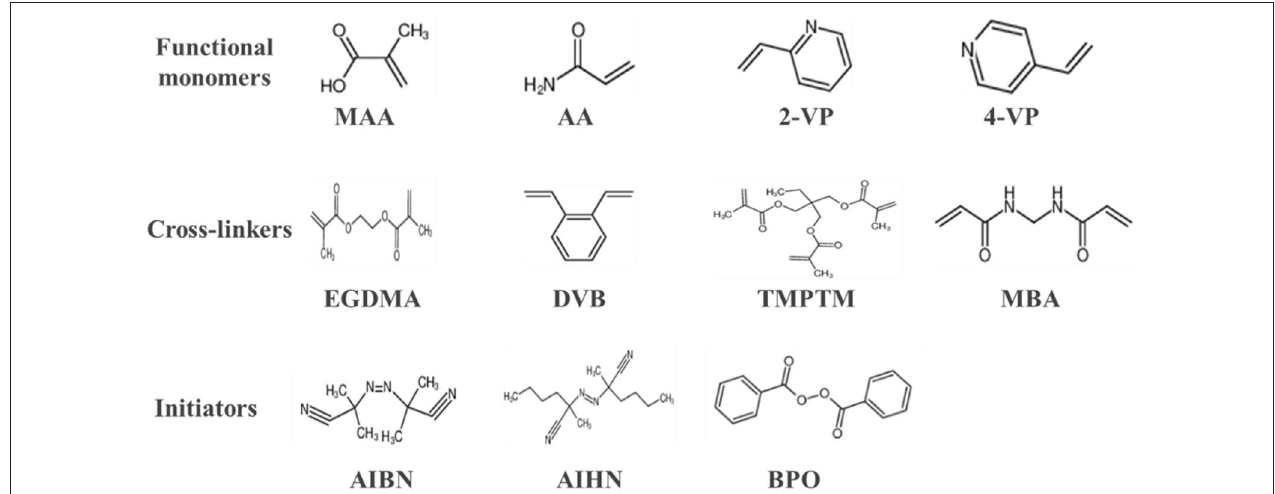
FIGURE 2 | Some commonly used MIPs reaction reagents involving functional monomers, cross-linkers, and initiators. MAA, methacrylic acid; AA, acrylic acid; 2-VP, 2-vinyl pyridine; 4-VP, 4-vinyl pyridine; EGDMA, ethylene glycol dimethacrylate; DVB, divinylbenzene; TMPTM, trimethylolpropane-tri methacrylate; MBA, methylene